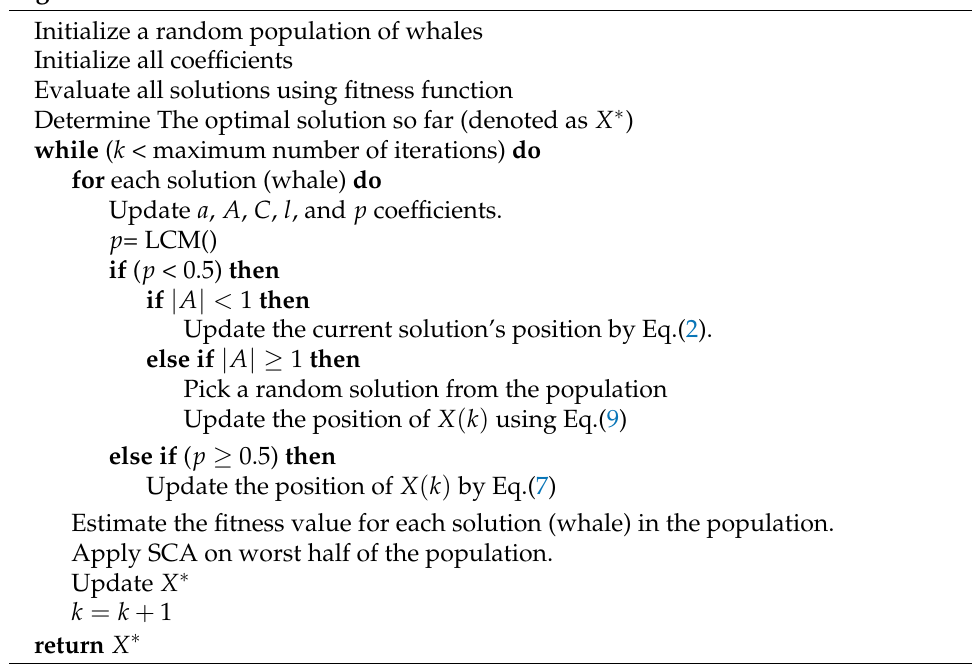
Algorithm 4 Pseudo-code of